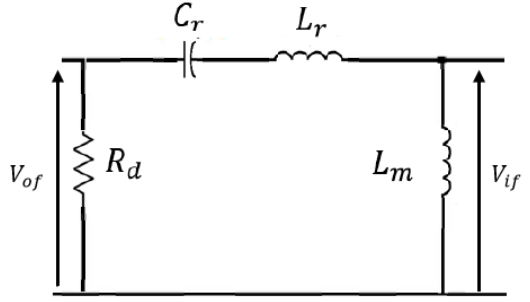
Figure 5. FHA equivalent model of LLC converter in V2X